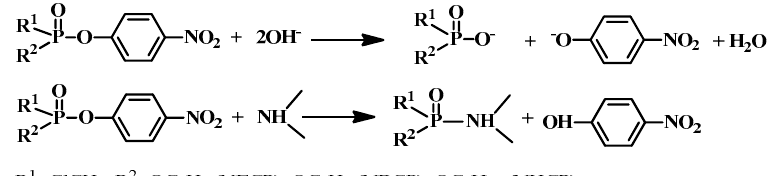
Figure 7. Scheme of alkaline hydrolysis of phosphorus acid esters.